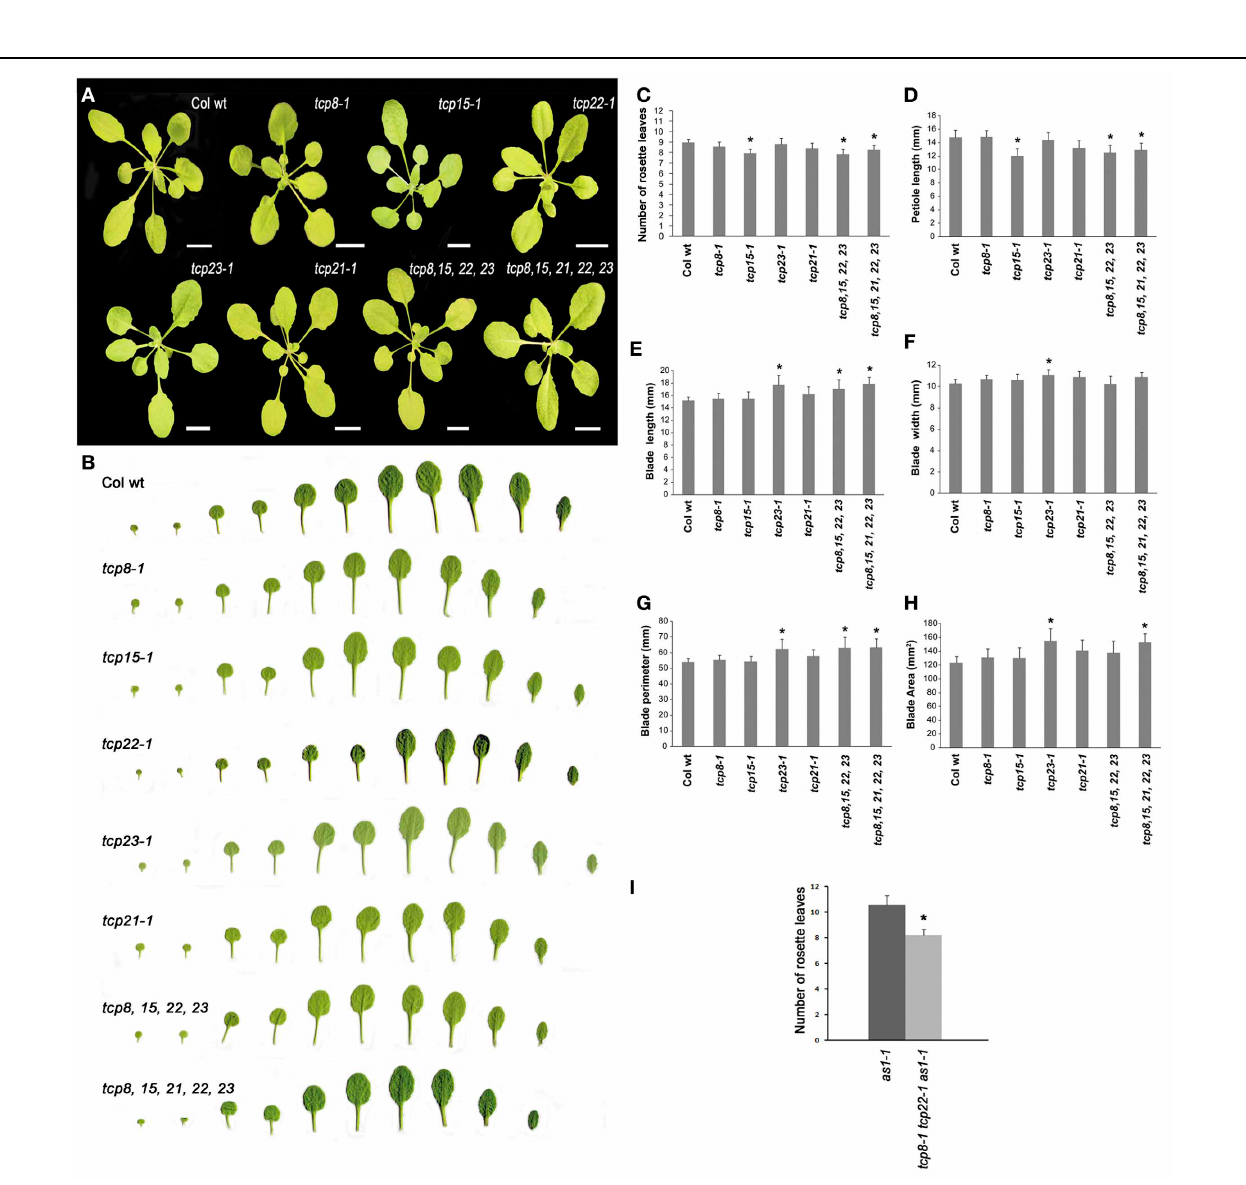
FIGURE 4 | Phenotypic characterization of class I TCP gene mutants. (A) Rosettes at bolting stage of Col wt, the single mutants tcp8-1, tcp15-1, tcp22-1, tcp23-1 , and tcp21-1 , the quadruple mutant tcp8-1 tcp15-1 tcp22-1 tcp23-1 (tcp8, 15, 22, 23) and the pentuple